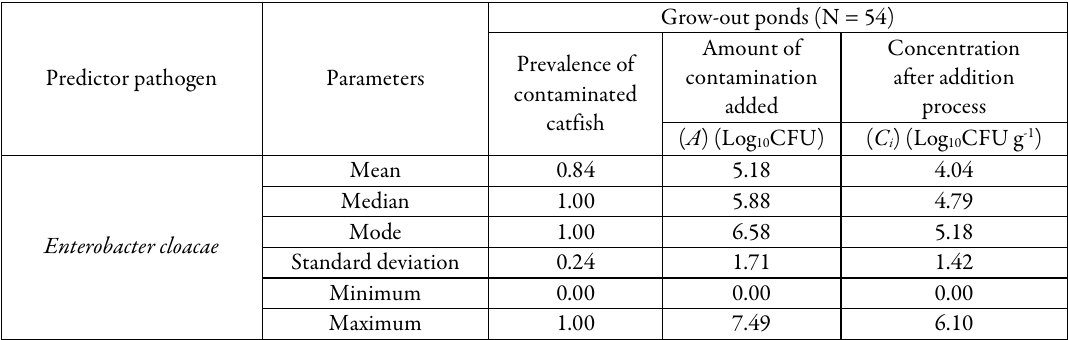
Table 1. Variables inputted into FDA-iRisk software for stochastic quantification of variability in the concentration of the pathogen in C. gariepinus Predictor pathogen Parameters